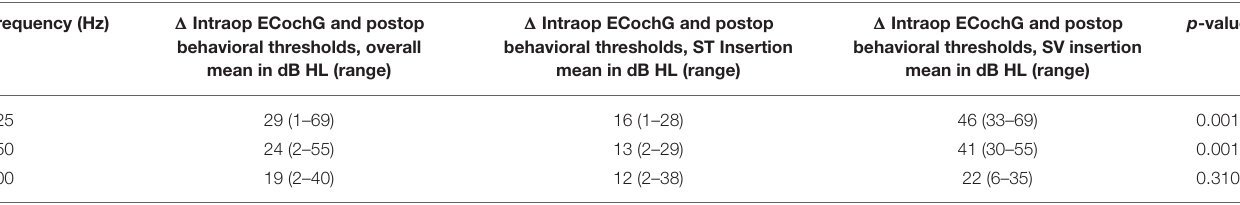
TABLE 2 | The mean absolute difference between intraoperative electrocochleography (ECochG) thresholds and postoperative behavioral thresholds at 125, 250, and 500Hz frequencies are shown in the overall cohort. Frequency (Hz)